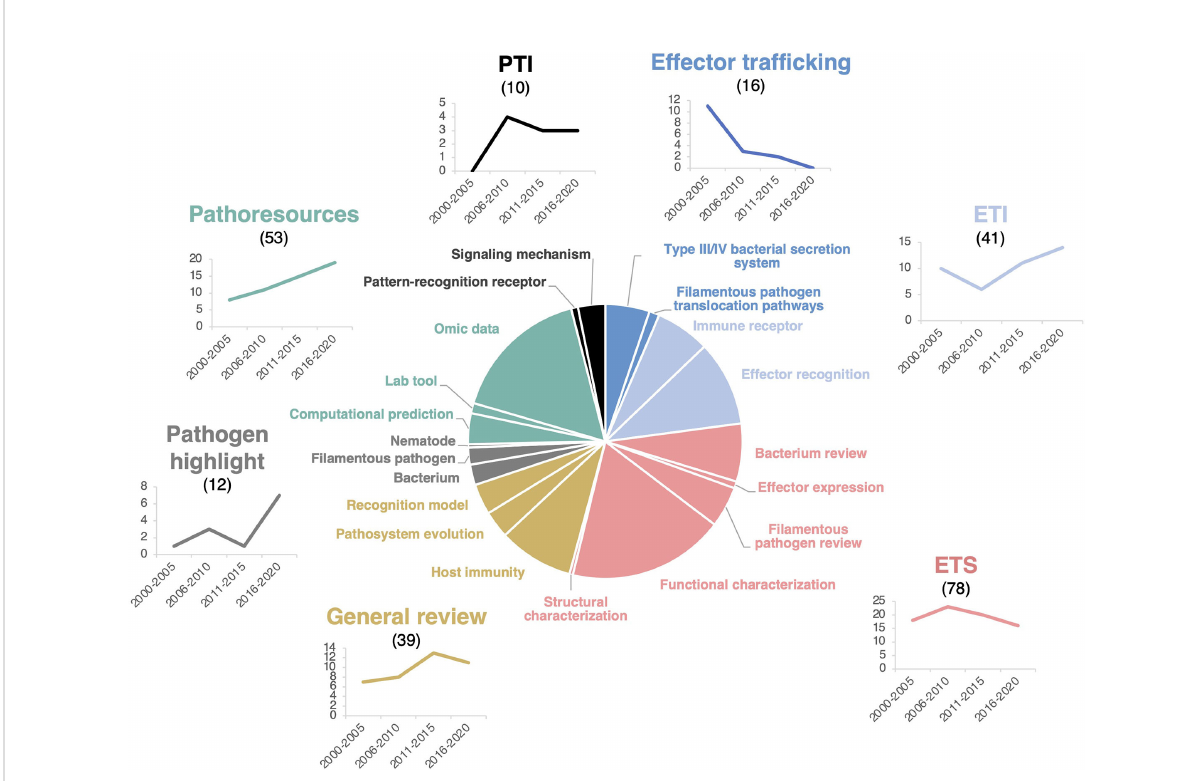
FIGURE 2 HIPEs pertain to seven main research topics. Pie chart displaying the seven main research topics and 20 sub-topics addressed by the HIPEs and their publication trends over time. The main research topics, sub-topics, and trendlines associated are color-coded as indicated in Figure S3. Sub-topics are indicated as separated pie segments within a main topic. The categorization of each HIPE was based on iterative expert reading and keyword association of the entire HIPE collection. Numbers above the main research topics indicate the total number of HIPEs for each topic. Trendlines indicate the number of HIPEs for each topic according to one six-year time frame (low number of publications during this frame) and four fi ve-year time frames: 2000-2005, 2006-2010, 2011-2015, and 2016-2020, respectively. PTI: Pattern-triggered immunity; ETI: Effector-triggered immunity; ETS: Effector-triggered susceptibility. The percentage of reviews within each topics is as follow: effector traf fi cking (63%), ETI (27%), ETS (42%), general reviews (100%), pathogen highlight (100%), pathoresources (21%), and PTI (60%). The raw data used to build this fi gure are available in the Dataset